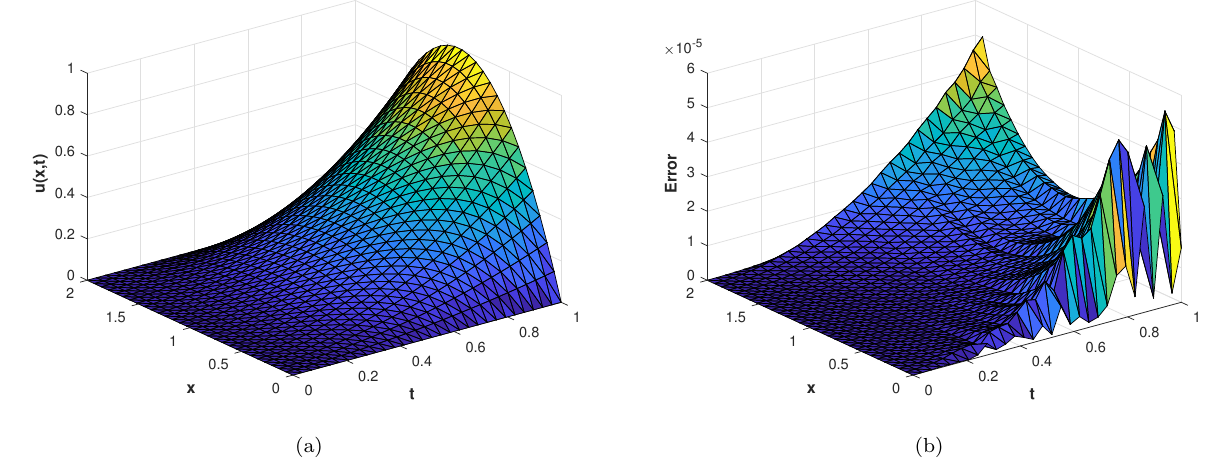
= 30 , N S = = 30, G N G N